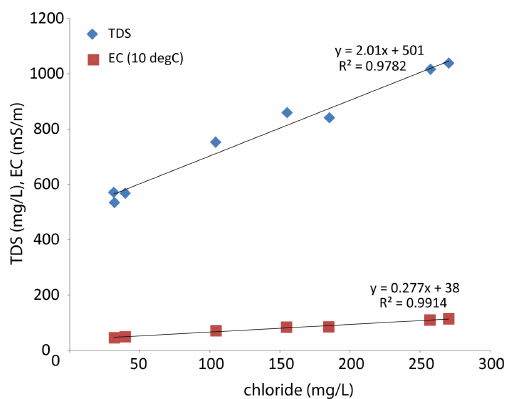
Fig. 8. Relation between measured chloride and measured and cal- culated electrical conductivity and TDS,